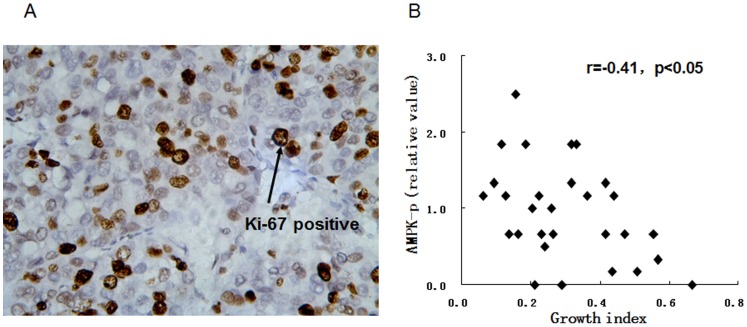
The correlation between AMPK activity and cell proliferation of HCC.(A) The growth index of HCC was represented by the expression of Ki-67. (B) Significant negative correlation between AMPK activity and growth index in HCC (r = −0.41, p<0.05).